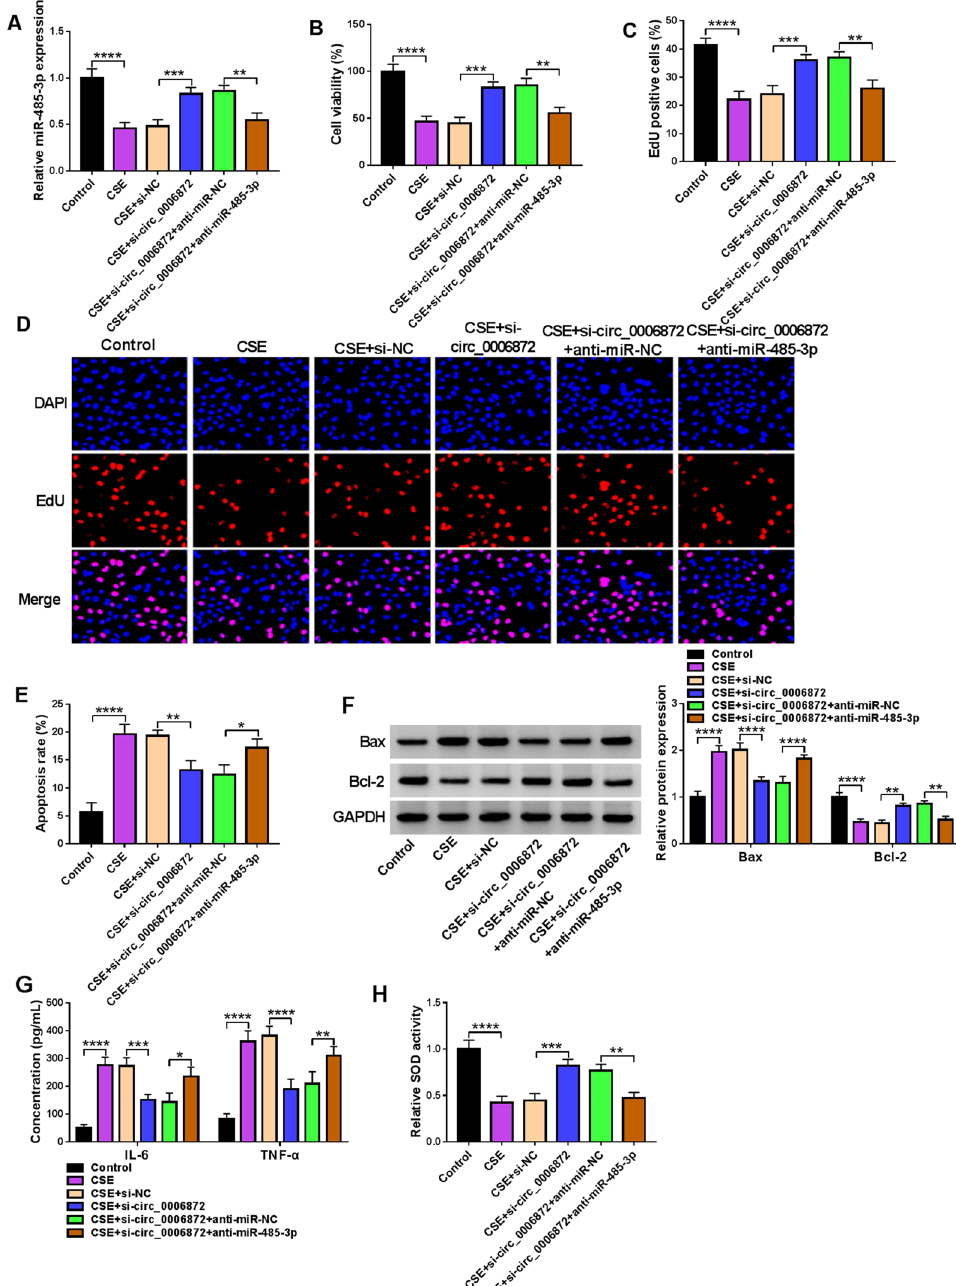
Fig. 4 Knockdown of circ_0006872 attenuates CSE-induced 16HBEC injury via miR-485-3p. A–H 16HBECs were co-transfected with si-circ_0006872 and/or anti-miR-485-3p, followed by 2% CSE exposure for 24 h. A Transfection efficiency. B – D 16HBEC proliferation analysis. E 16HBEC apoptosis detection. F Levels of Bax and Bcl-2 in 16HBECs. G Levels of IL-6 and TNF-α in 16HBECs. H Measurement of SOD content in 16HBECs using a commercial kit. * P < 0.05, ** P < 0.01, *** P < 0.001, **** P <